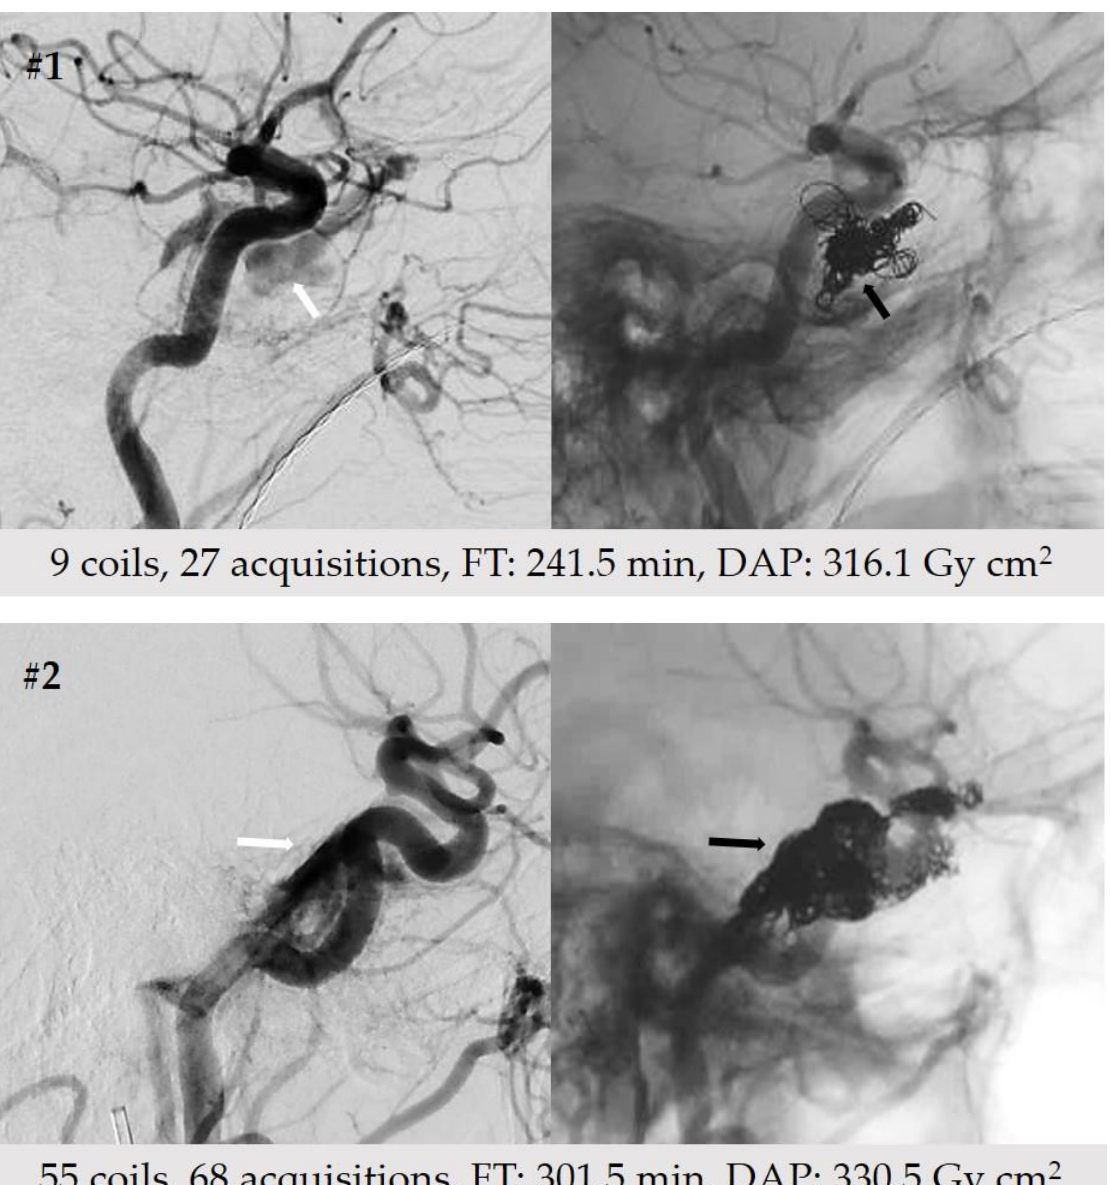
Figure 3. Dosimetrics of two exemplary patients with indirect fistulas. Patient #1 was endovascularly treated with the lowest (n = 9) and patient #2 with the highest number of coils (n = 55) in our study cohort. White arrows point to early filling of the cavernous sinus with contrast. Black arrows indicate implanted coils within the fistulous compartment.